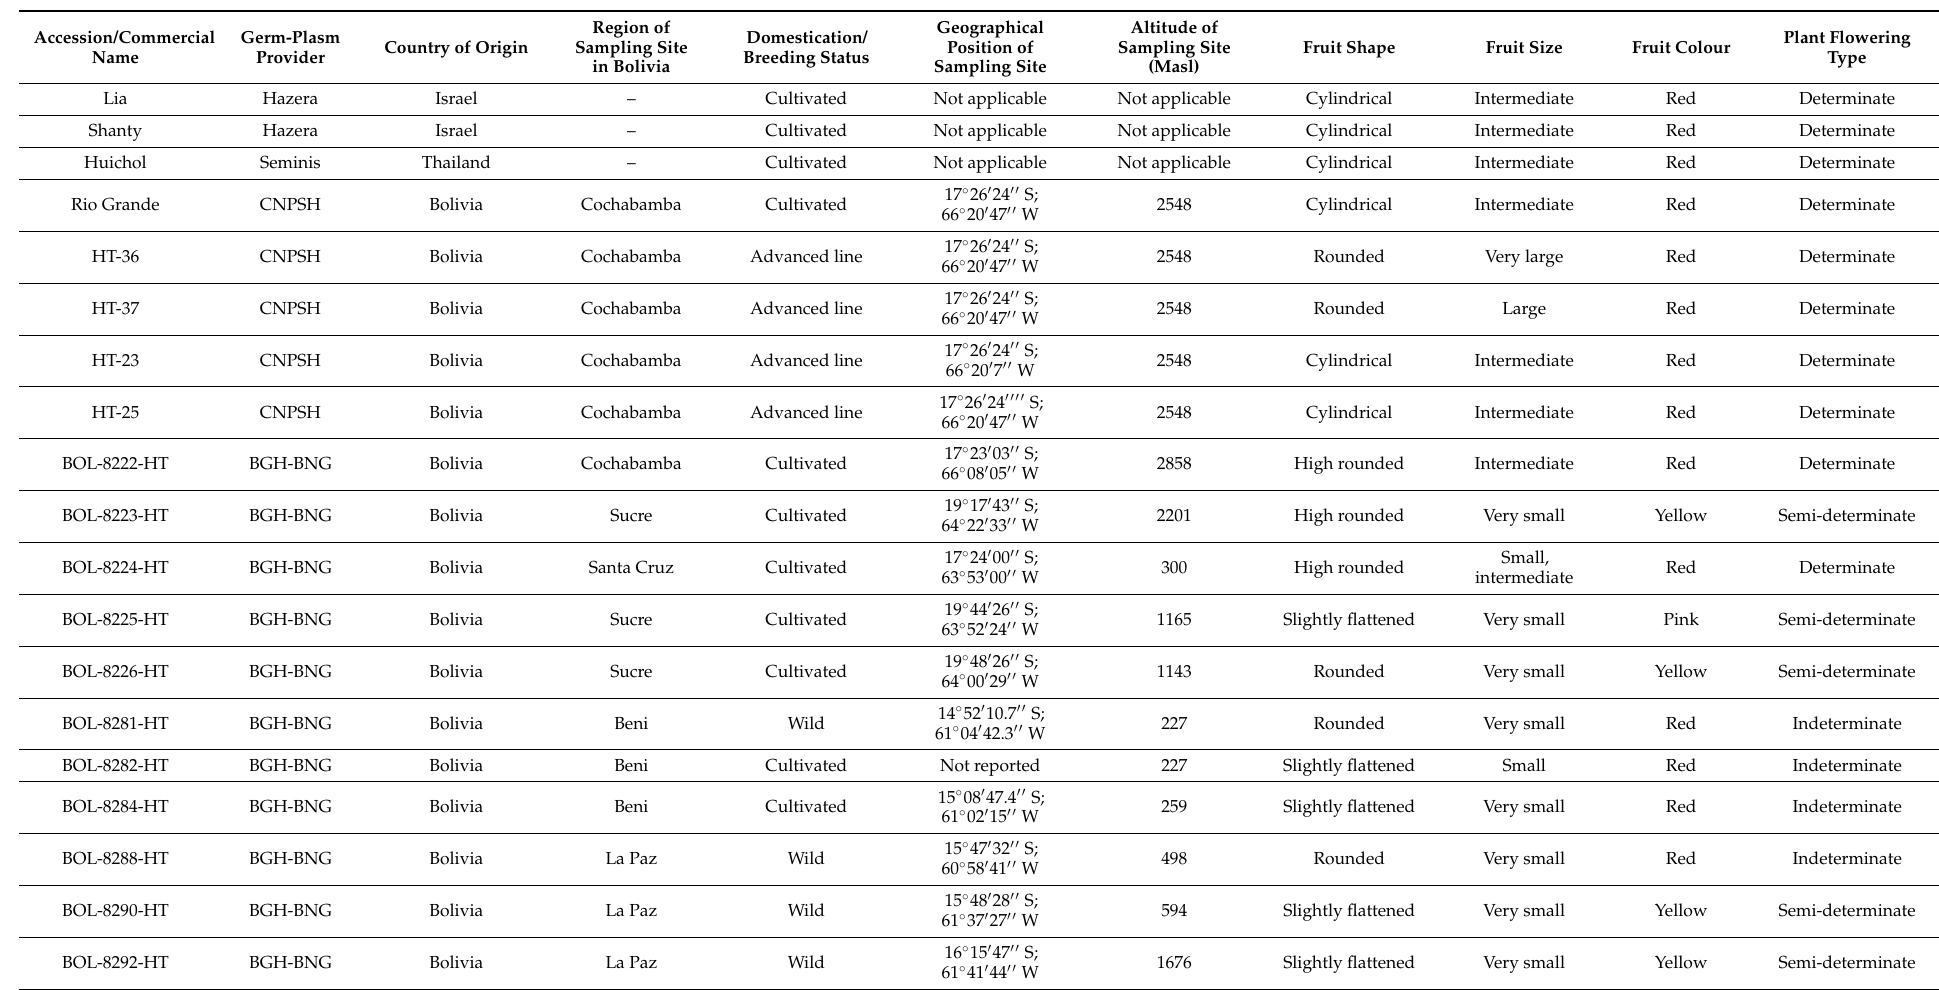
Table 1. Description of the 28 tomato accessions used in this study.